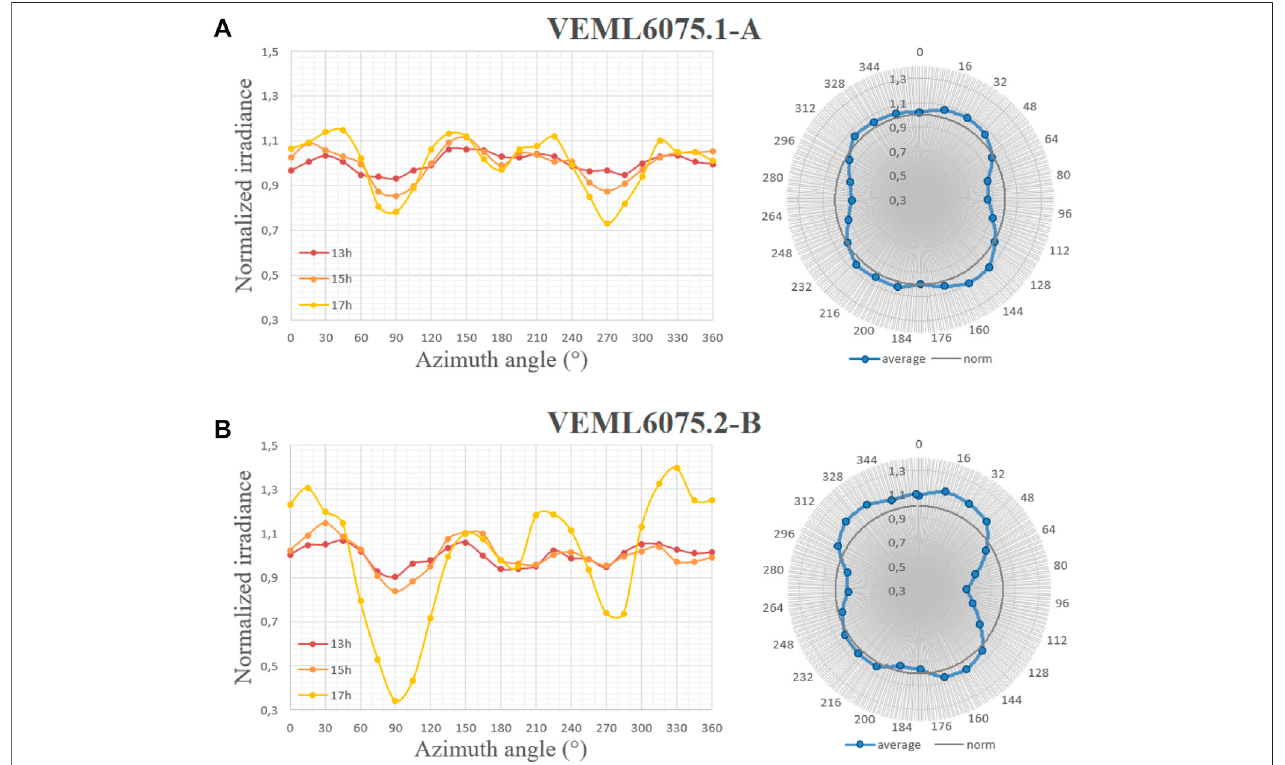
FIGURE 13 | Azimuth response of the channel A of the sensor VEML6075.1 (A) and the channel B of the sensor VEML6075.2 (B) : Output signal for different azimuth angles at different hours (left) and mean azimuth response (right) .